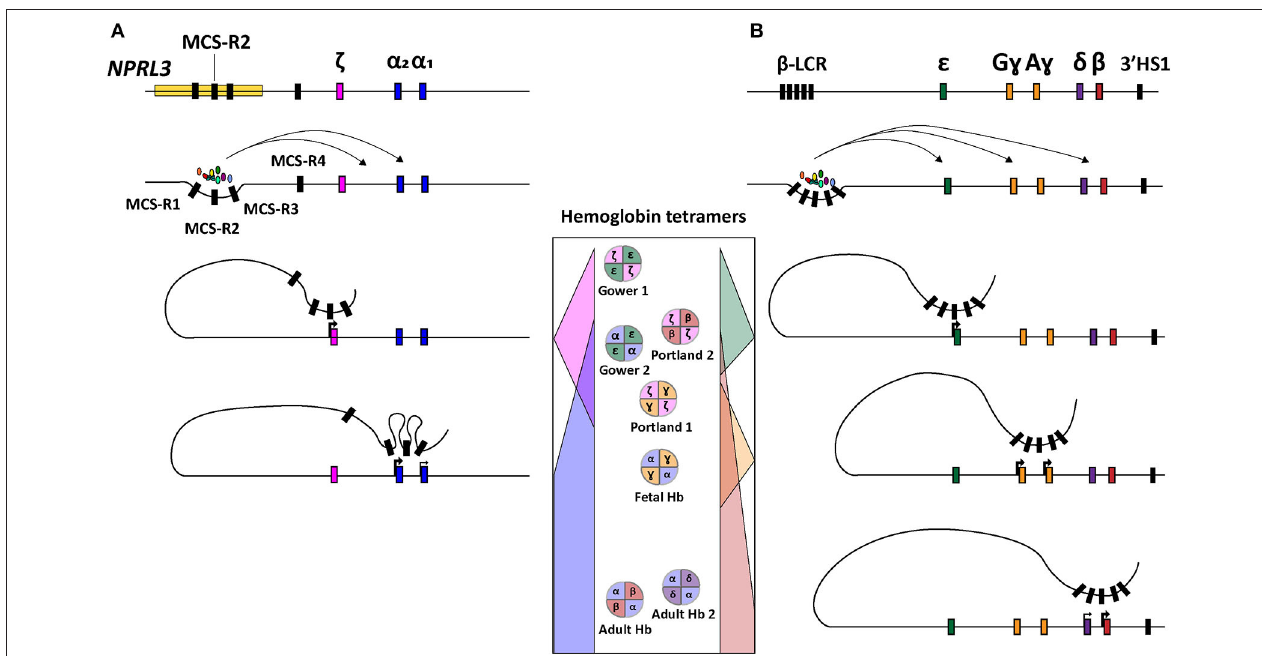
FIGURE 2 | Schematic representation of hemoglobin regulation. (A) Structure of the α -globin locus showing the recruitment of tissue-specific transcription factors at the distal regulatory regions (MCS-R1-4) and subsequent sequential chromosomal looping directing the orderly expression of ζ -, α 2 -, and α 1 -globin. (B) Structure of the β -globin locus depicting the recruitment of tissue-specific transcription factors at the distal regulatory elements (LCR) and ensuing sequential chromosomal looping governing orderly expression of ε , G È , A È , δ , and β -globin. In the center, the concomittant hemoglobin tetramer variants are displayed according to the chronological order of human development